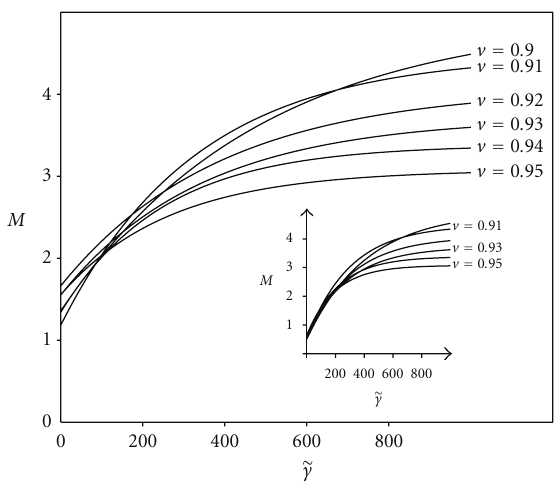
Figure 3: Measure M = tan( ϕ a / 2), where ϕ a is the adhesion angle, as a function of dimensionless reduced adhesion constant (cid:3) γ for the vesicle relative volumes v = 0 . 9–0.95. Curves show the fits of function from (7) where only k is a free parameter. The inset shows the fit, where the constraint M 0 is released, and the data is fitted using the function defined in (7) for the two free parameters: M 0 and k .